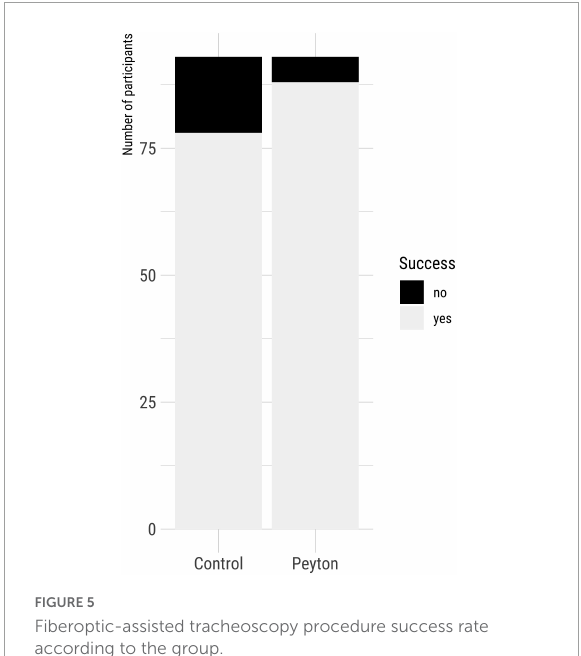
FIGURE5 Fiberoptic-assisted tracheoscopy procedure success rate according to the group.